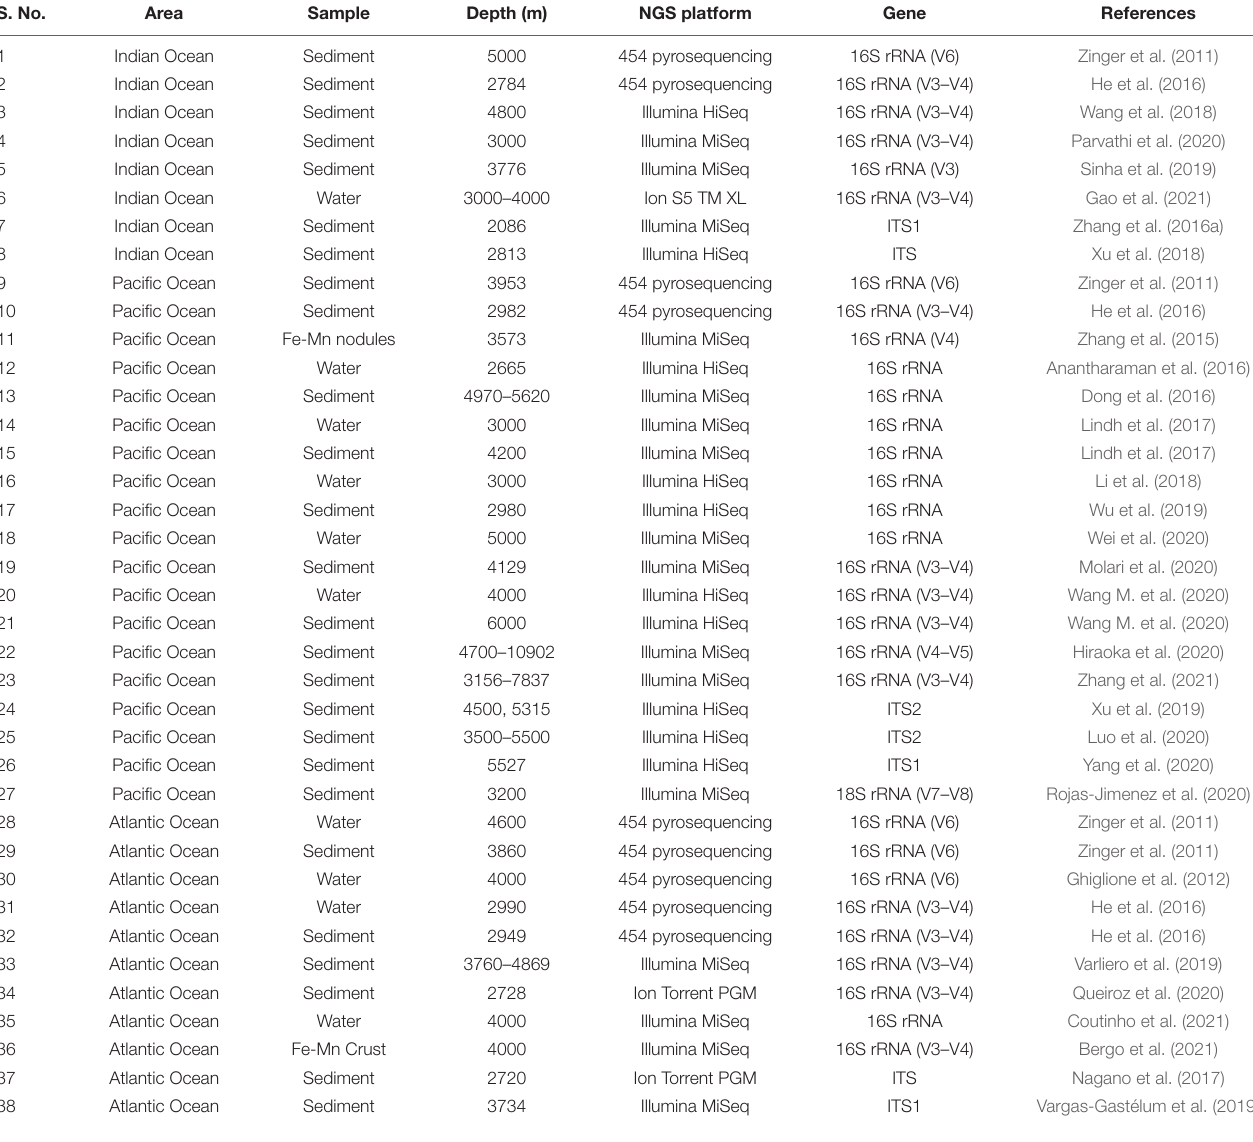
TABLE 1 | Un-cultured bacterial and fungal diversity reported (last 10 years) from the abyssal regions of different Oceans using different next-generation sequencing platforms. S.